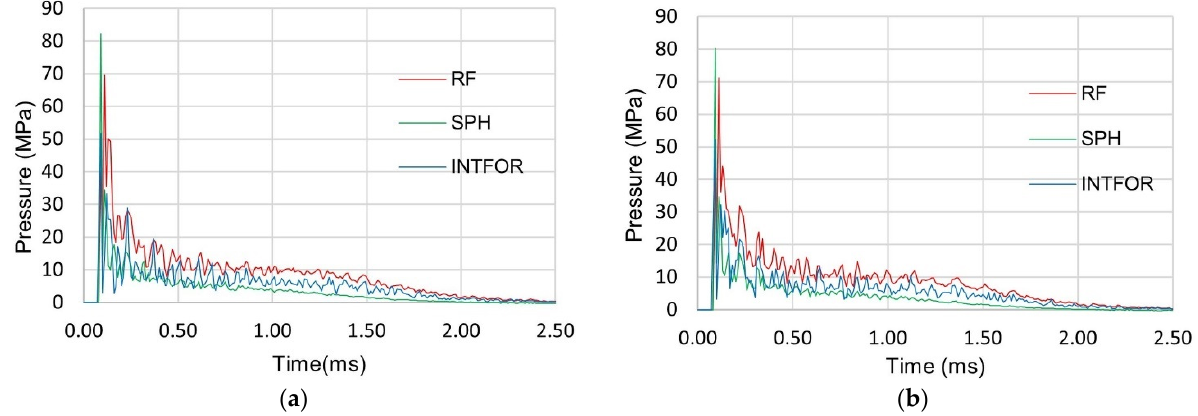
Figure 22. Pressure at center of impact for RF, SPH, and INTFOR, using various EOS: ( a ) EOS G; ( b ) EOS LP_00.